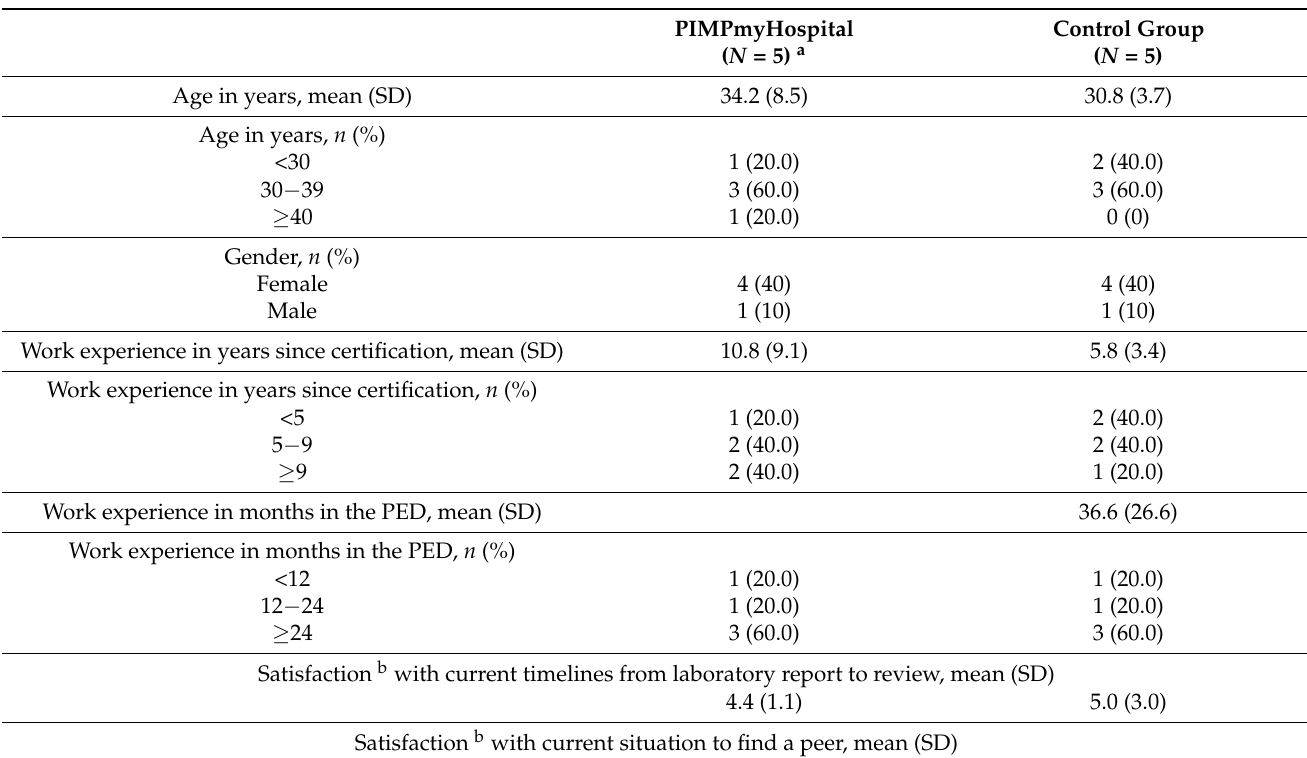
Table 1. Baseline characteristics of participants.